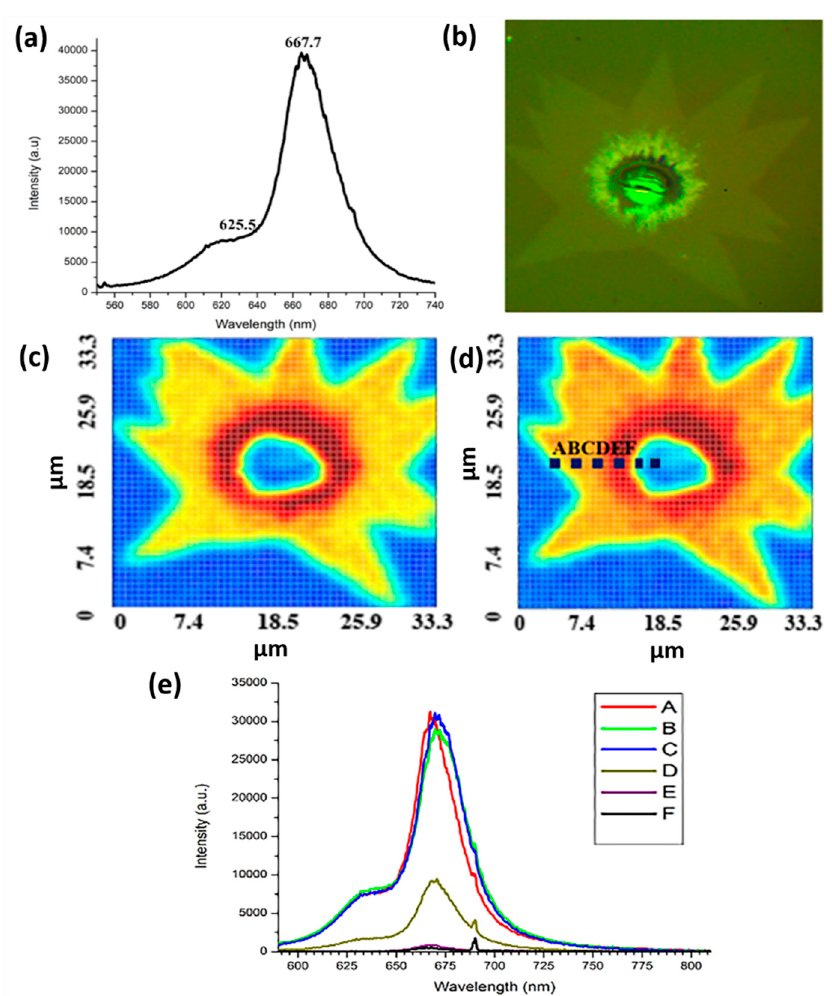
Figure 5. ( a ) PL measurement results of MoS 2 sample. ( b ) OM image of the selected PL mapping range. ( c , d ) PL mapping at 625 and 667 nm. ( e ) PL measurement result of the test piece marked by the blue dotted line in ( d ).